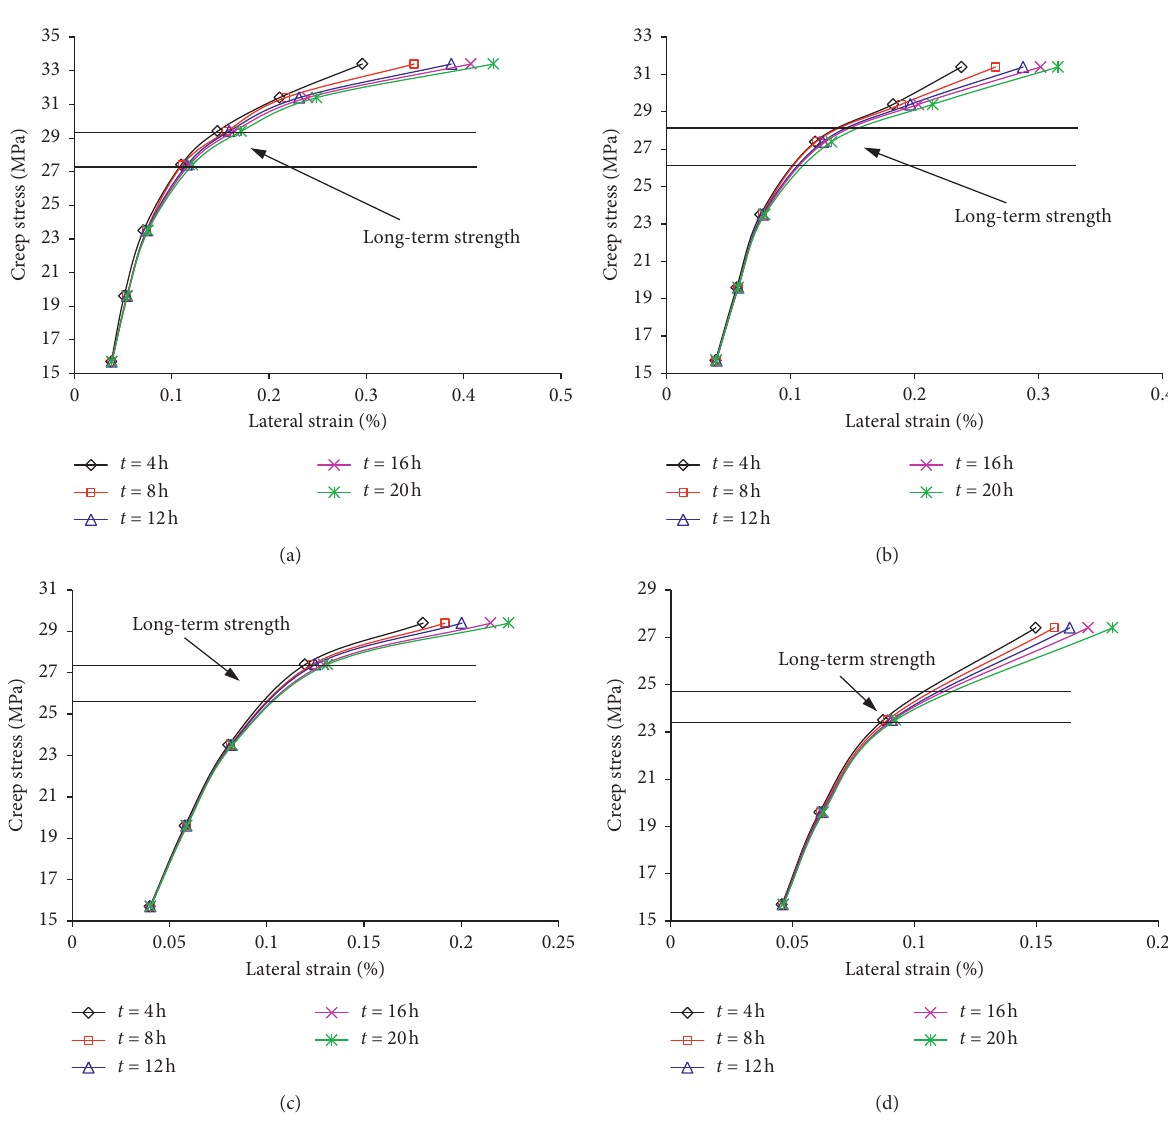
Figure 5: Lateral isochronous stress-strain curves of rock specimens with different initial damage: (a–d) the rock specimens with initial damage state D 1 , D 2 , D 3 , and D 4 ,